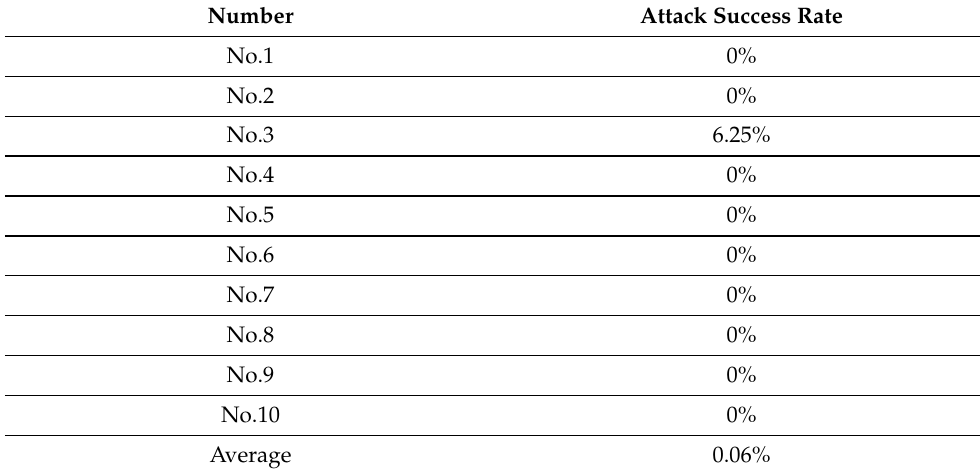
Table 15. Dodging attack success rate after defense.